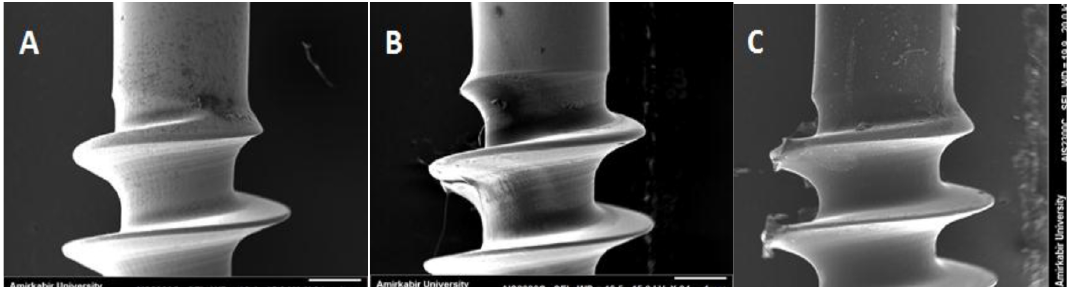
Fig. 2. SEM images of the various screw surfaces (A) uncoated titanium screw, (B) coated screw by deposition methods, (C) coated screw by casting method